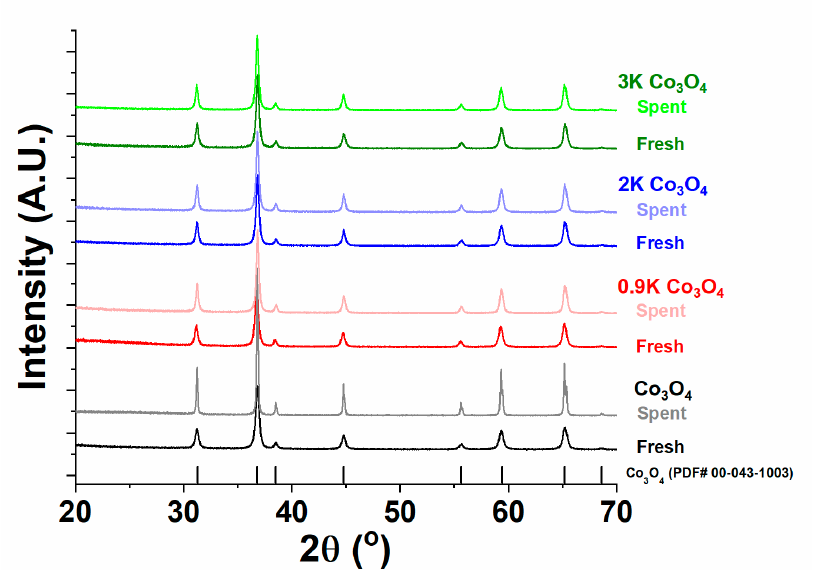
Figure 6. X-ray diffraction patterns of fresh and spent Co 3 O 4 catalysts with varying K loadings. Short vertical lines indicate the position of reflections of Co 3 O 4 (PDF# 00-043-1003) for reference. The XRD patterns of the Mn 3 O 4 catalysts with varying K loadings contain both Mn 3 O 4 (PDF# 01-070-9110) and bixbyite Mn 2 O 3 (PDF# 01-071-0636) reflections in all fresh samples (Figure 7), but